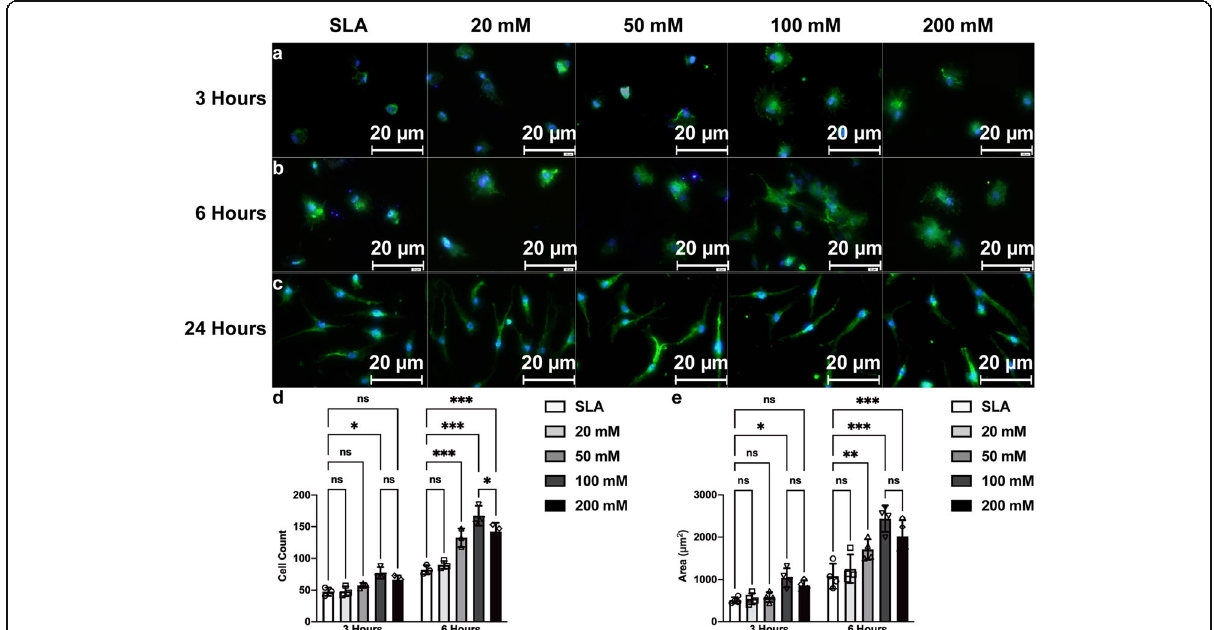
Fig. 5 Fluorescence microscopy images of BMSCs cultured on SLA surfaces treated with different concentrations of sodium bicarbonate for 3 h ( a ), 6 h ( b ), and 24 h ( c ). Number of BMSCs in all groups at 3 and 6 h after cell seeding ( d ). The cellular area was measured with ImageJ for all groups at 3 and 6 h ( e ). Images were taken by selecting ten random areas, and data are presented as the mean ± standard deviation ( n = 3, * P < 0.05; ** P < 0.01; *** P < 0.001)